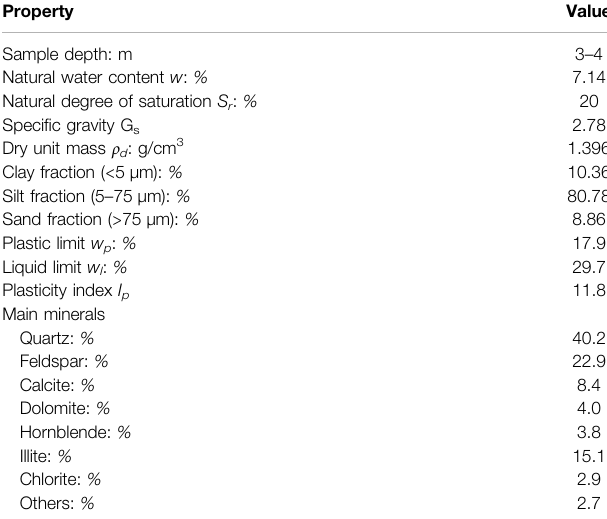
TABLE 1 | Geotechnical characteristics of the studied loess. Property Value